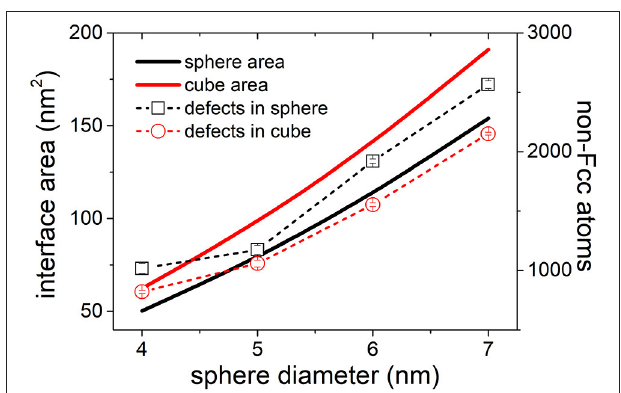
FIGURE 7 | Number of non-fcc atoms vs. sphere diameter for both spherical and cubic particles after the relaxation process. The cubic particles are of the same volumes as the spherical ones. Cu–Ag interface areas are also given for